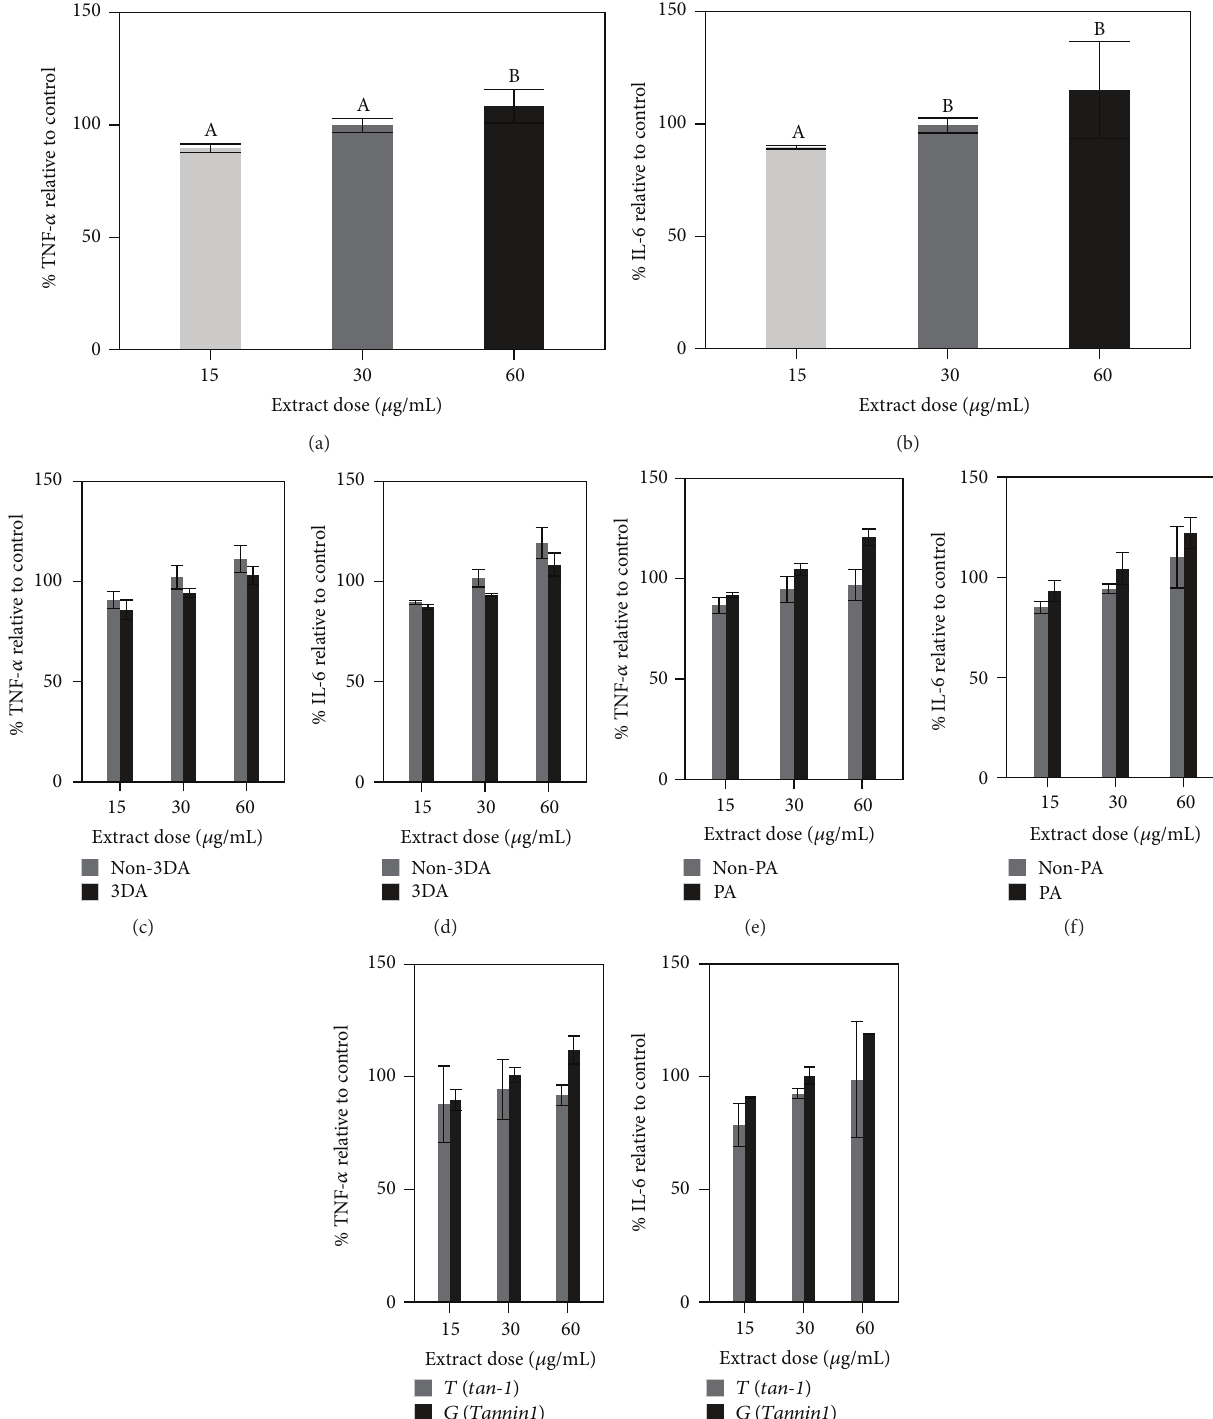
Figure 4: Sorghum bran extracts differentially modulate TNF- 𝛼 and IL-6 production in RAW 264.7 cells. Cells were seeded in 96-well plates, incubated overnight, and pretreated with sorghum bran extracts at concentrations of 15 𝜇 g/mL, 30 𝜇 g/mL, and 60 𝜇 g/mL for 1 hour before LPS stimulation (1 𝜇 g/mL) for 18 hours. (a) Effect of extract dose on TNF- 𝛼 , (b) effect of extract dose on IL-6, (c) effect of 3-deoxyanthocyanidin- containingaccessionsonTNF- 𝛼 ,(d)effectof3-deoxyanthocyanidin-containingaccessionsonIL-6,(e)effectofproanthocyanidin-containing accessions on TNF- 𝛼 , (f) effect of proanthocyanidin-containing accessions on IL-6, (g) effect of Tannin1 on TNF- 𝛼 , and (h) effect of Tannin1 on IL-6. Results are expressed as percentage of extract-treated cells versus negative controls (no extract added). Error bars represent the means of triplicate experiments ± SD. For (a) and (b), concentrations share the same letter if they are not significantly different from each